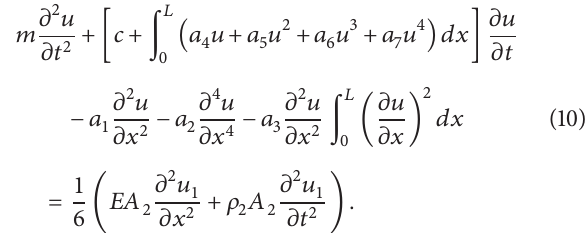
Figure 6: Mechanical model of a high-aspect-ratio SMA composite